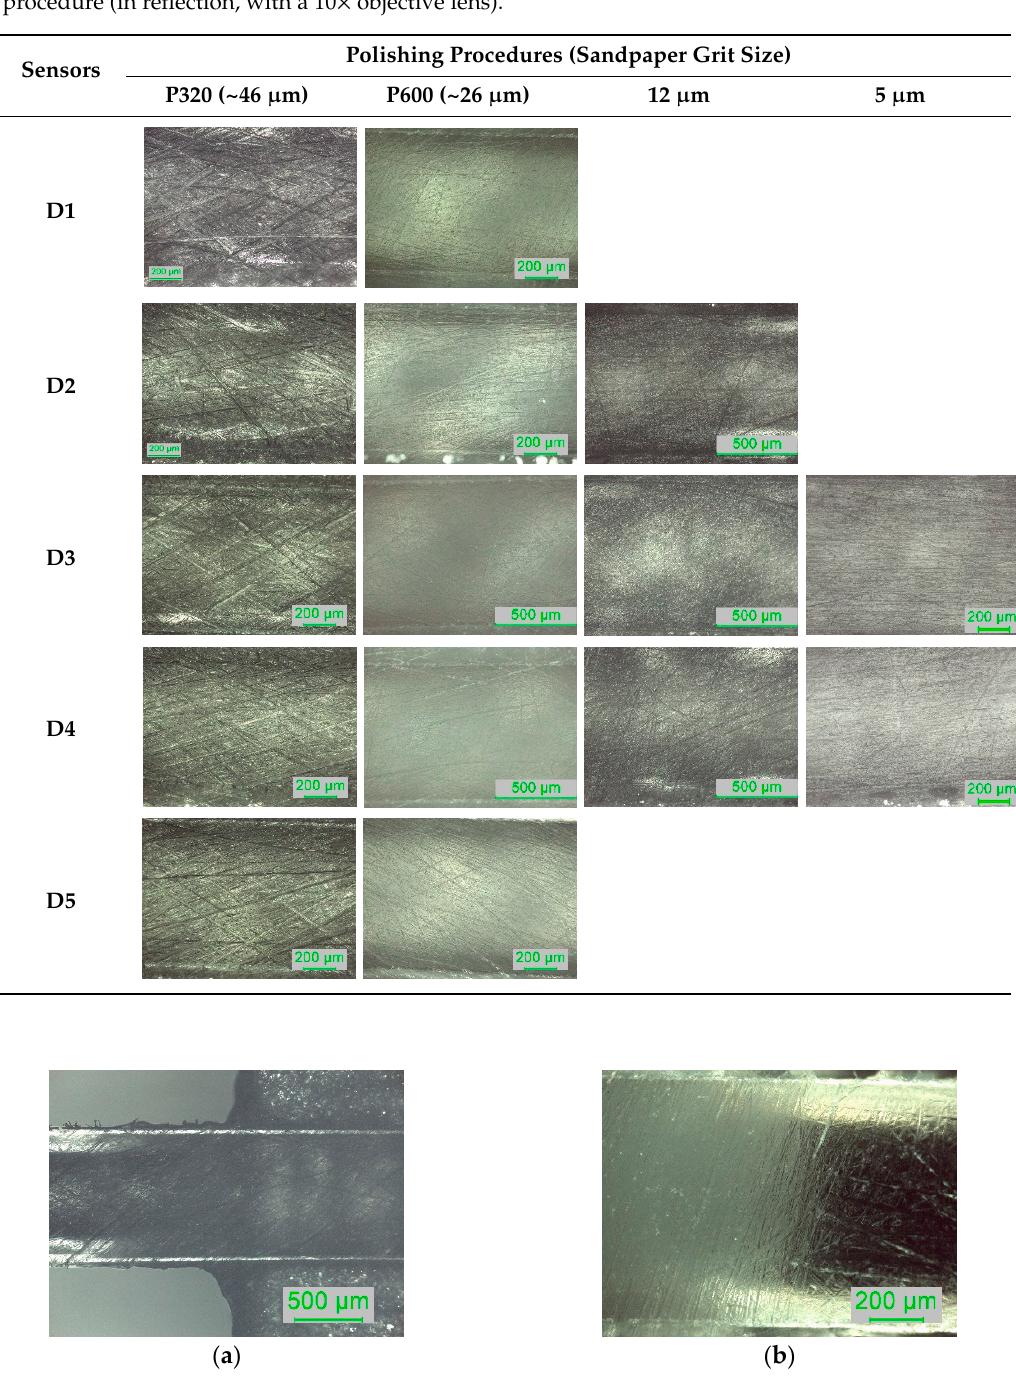
Figure 5. Optical microscopy images of the interface between the sensing region and the unpolished POF: ( a ) sensor D3 (P320, P600, 12 µm grit size); ( b ) close-up of sensor D1 (P320 and P600). The thickness of the sensing region was calculated as the average value and standard deviation of several measurements taken at different points on the surface, obtained from different optical microscopy images (see Table 3). As an example, in Figure 6 are depicted two images of optical microscopy with several performed measurements. Only images obtained with a 5× objective lens were used, as only this magnification allows to view completely the fiber diameter. After polishing with P320 sandpaper, the measurements were mostly not performed as it was very difficult to obtain clear images where the limits of the sensing region could be easily identified.